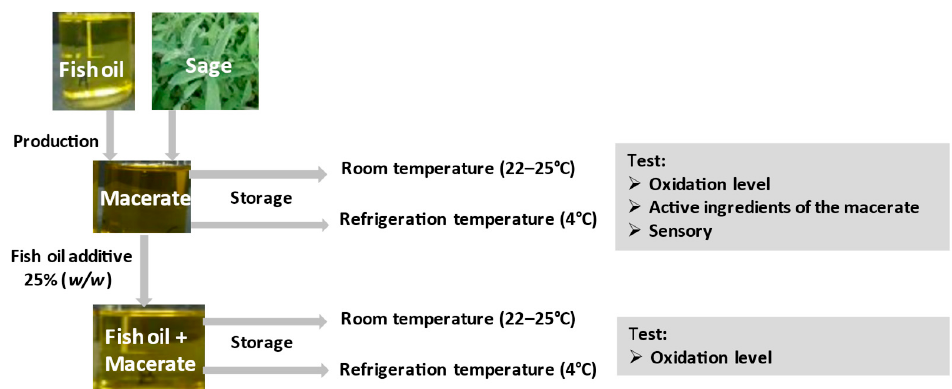
Figure 1. The scheme of the experiment .